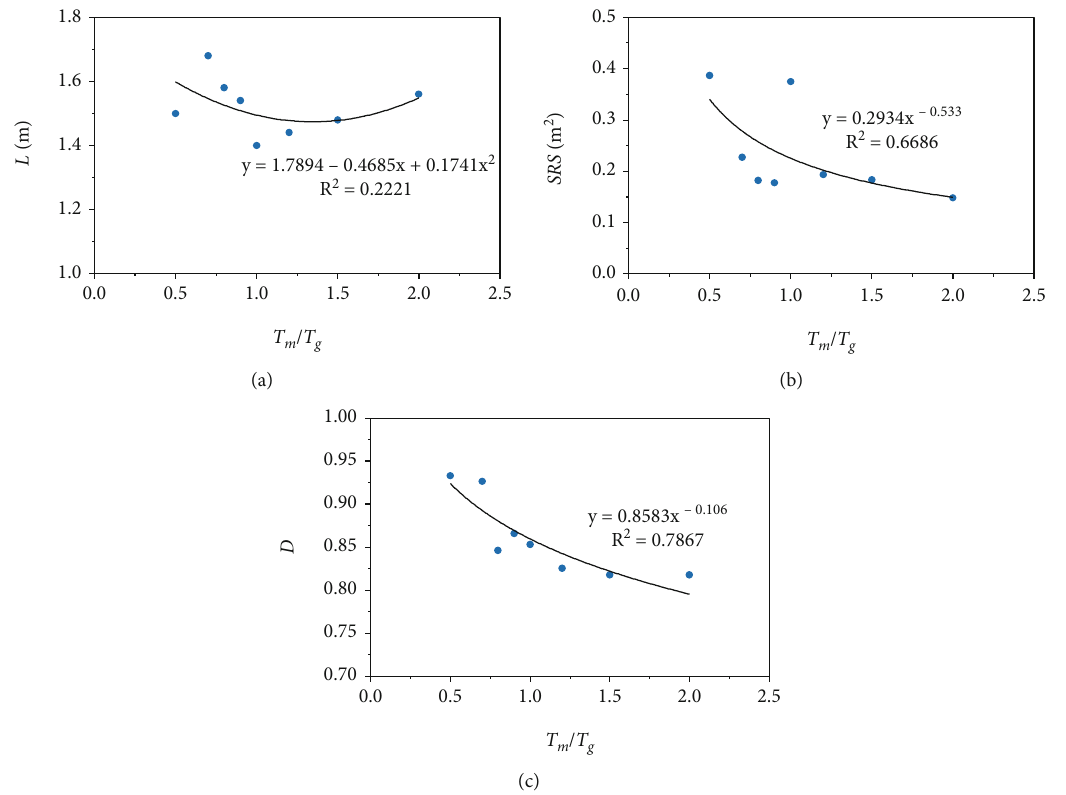
Figure 12: Geometric parameters of HF under di ff erent ratios of the tensile strength of the matrix to